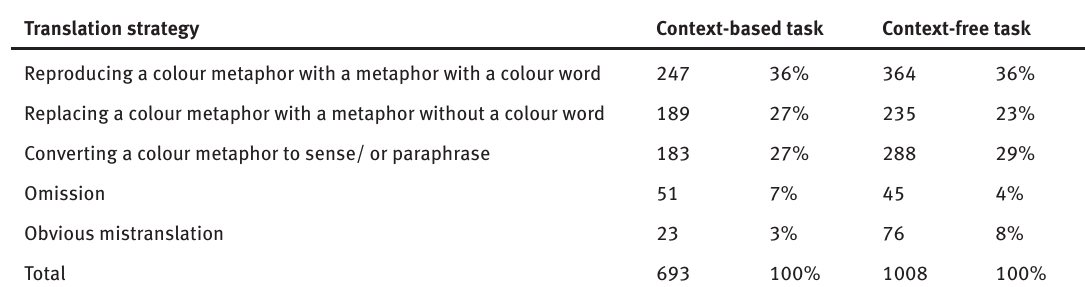
Table 3: Summary of the translation strategies used in the context-based and context-free translation